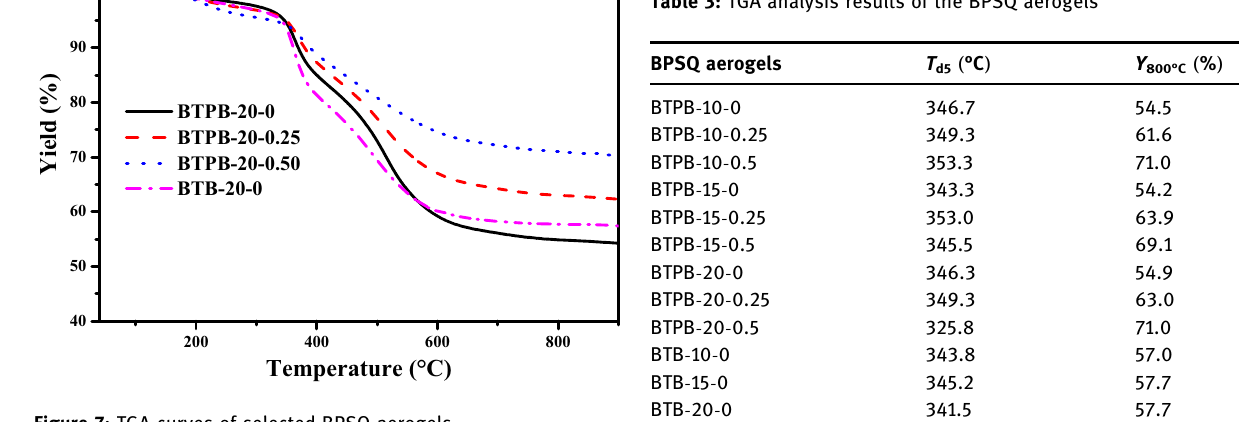
Figure 7: TGA curves of selected BPSQ aerogels.